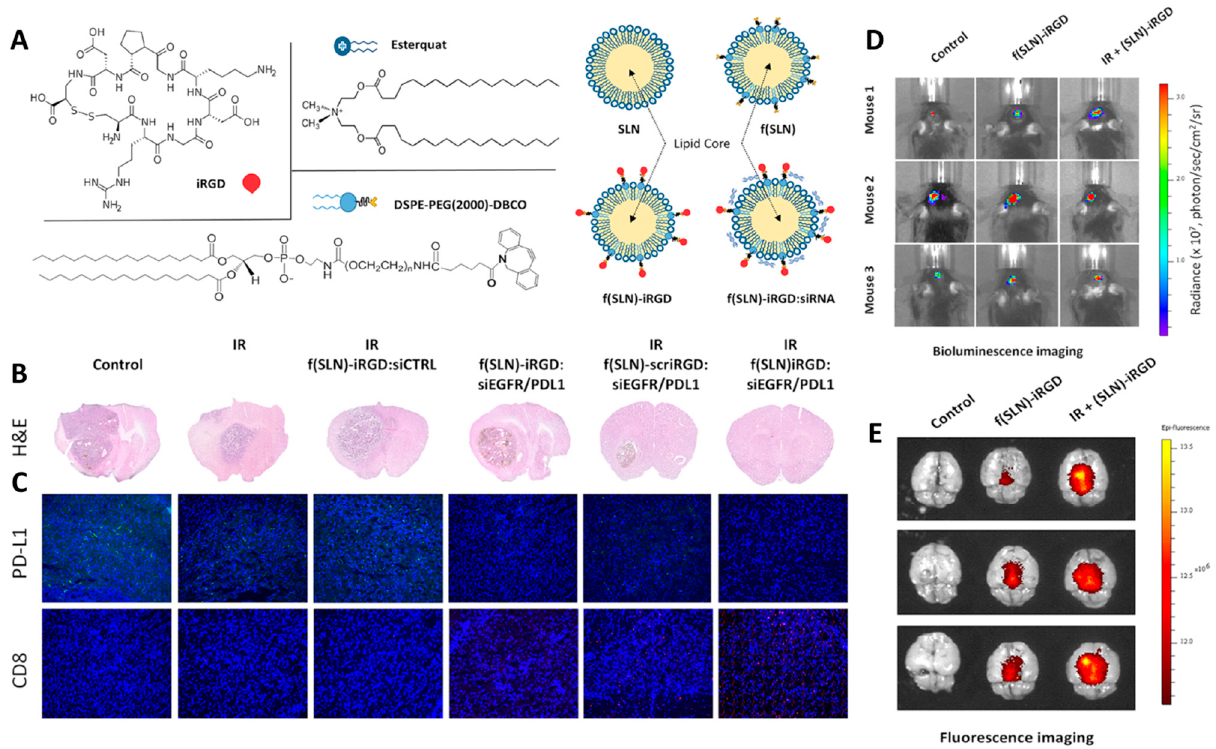
Figure 5. ( A ) Chemical structure and schematic of siRNA-loaded solid lipid NPs. ( B ) H and E images and ( C ) immunohistological analysis of brain sections after exposure to different treatments (anti-PD-L1 and anti-CD8 antibodies were used for immunohistochemistry). ( D ) Bioluminescence and ( E ) fluorescence images of the mouse brain treated with siRNA-loaded SLNs in the absence and presence of radiation therapy. Abbreviations: f(SLN): functionalized solid lipid nanoparticle, siCTRL: control scrambled siRNA, EGFR: Epidermal growth factor receptor, H and E: Hematoxylin and eosin, PDL1: Programmed death-ligand 1. Reprinted with permission from [181].